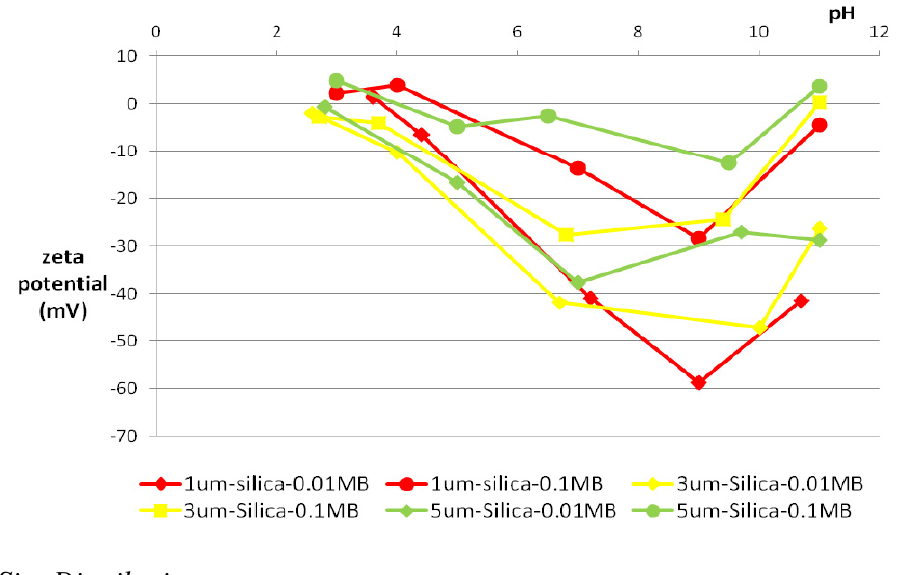
Figure 5. Zeta potential of silica particles in aqueous solution for different particle radii.